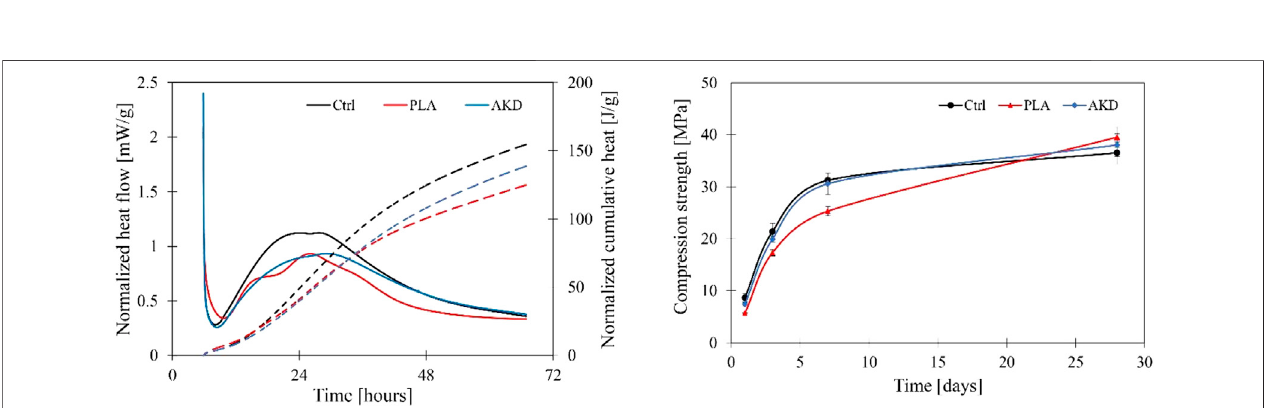
FIGURE 3 | Schematic representation of the conducted experimental plan to assess the in fl uence of HA on functional properties (top row) , the self-healing capacity of the analyzed mixtures (central row) and the evidence of bacterial activity in mortar (bottom row) .